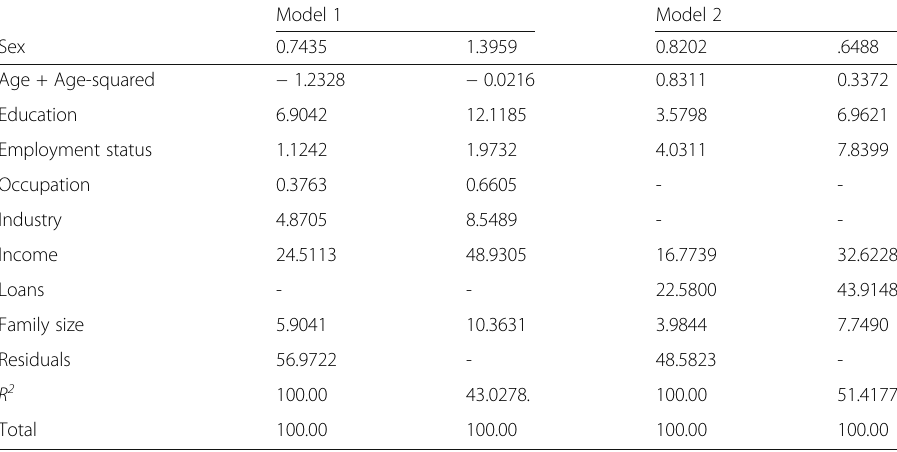
Table 4 Wealth inequality decomposed through multivariate variables (%) Model 1 Model 2